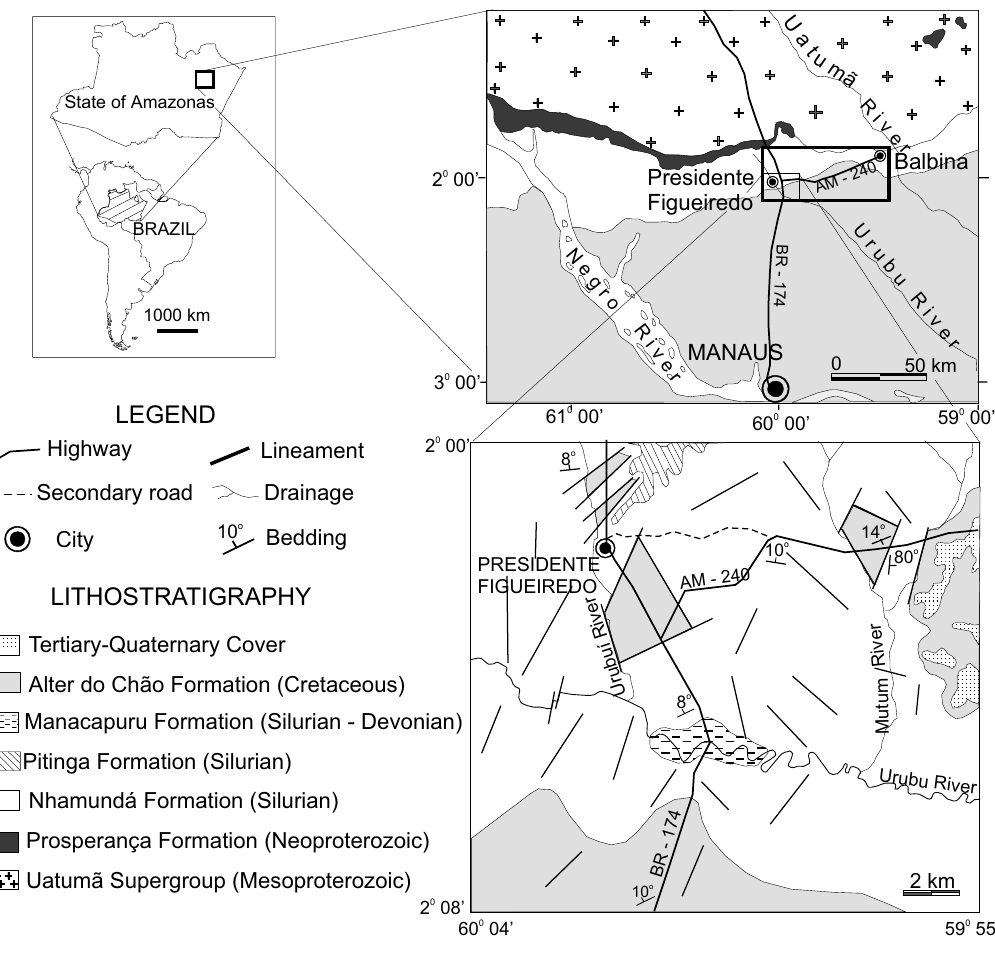
Fig. 1 – Location and geologic map of the Presidente Figueiredo municipality and the study area. (After Schobbenhaus and Campos 1984 and Nogueira et al. 1997